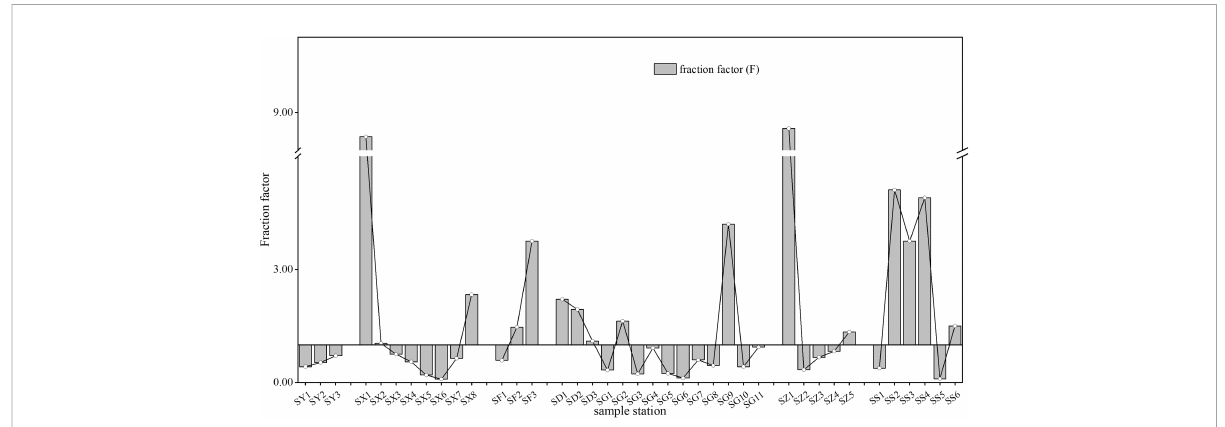
FIGURE 6 The fractionation factor (F) of lead (Pb 3 ) between the colloidal and truly dissolved phases. SY represents the Yellow River; SX represents the Xiaoqinghe River; SF represents the Yongfenghe River; SD represents the Xiaodaohe River; SZ represents the Zhimaihe River; SG represents the Guanglihe River; and SS represents the Shenxiangou